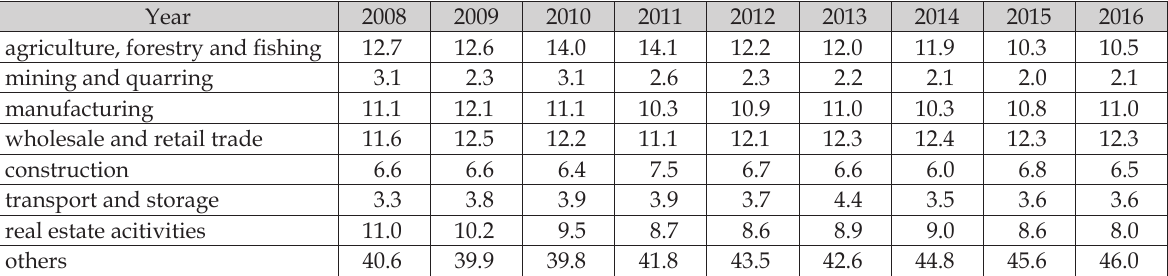
Table 1. Share of agriculture in GDP in % compared with some other acitivities.